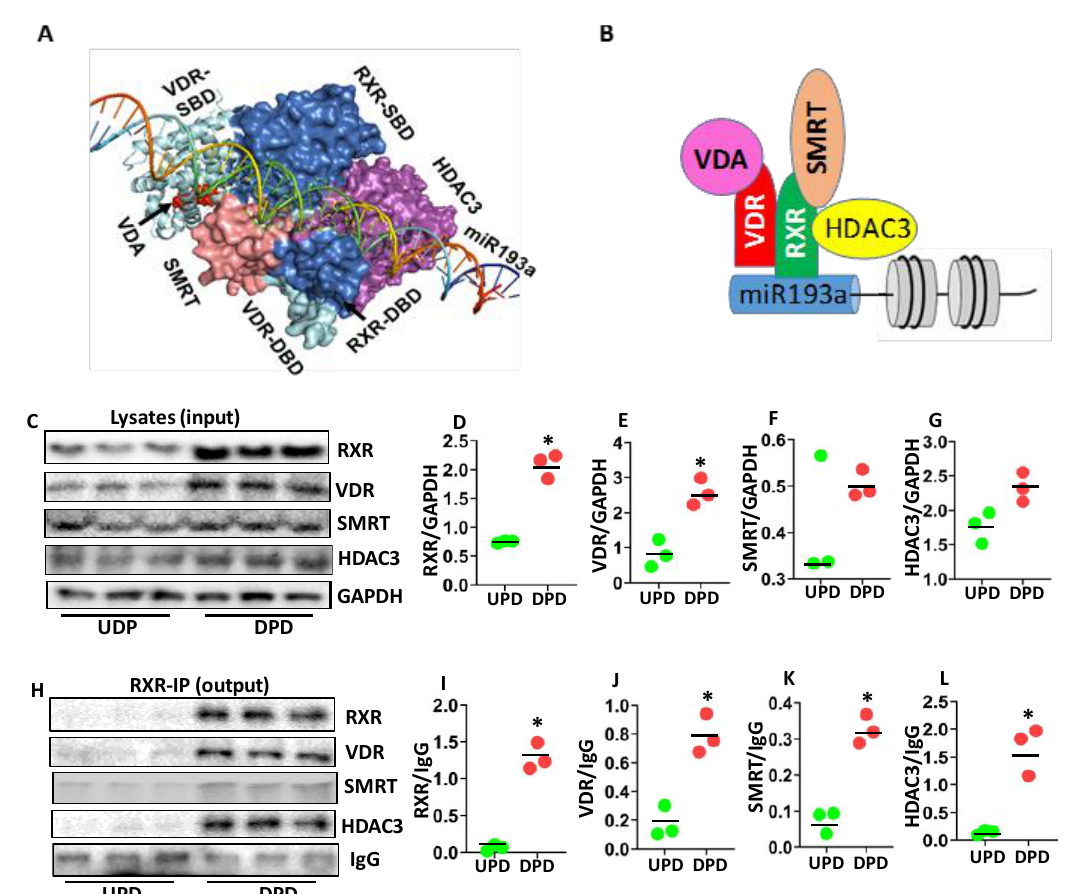
Figure 5. Analysis of VDR-RXR repressor complex. ( A ) The structural construct of the VDR-RXR repressor complex. The complex shows VDR (cyan) and RXR (marine blue) heterodimer. VDA (red) bound with VDR and RXR heterodimer interacts with miR193a promoter and recruits SMRT (pink) and HDAC3 (magenta) and forms a repressor complex. ( B ) A schematic diagram is displaying the formation of the VDR-RXR repressor complex at the miR193a promoter. The VDA bound VDR makes a heterodimer with RXR and recruits SMRT and HDAC3 and forms a repressor complex. ( C ) Protein blots of three different cellular lysates of UPDs and DPDs were probed for RXR, VDR, SMRT, HDAC3, and GAPDH. Gels of three independent lysates are displayed. ( D – G ). Cumulative densitometric data (protein GAPDH) are shown as dot plots. * p < 0.05 compared with respective UPD. ( H ) Cellular lysates from protocol C were immunoprecipitated (IP) with the RXR antibody. Protein blots of RXR-IP fractions were probed for RXR, VDR, SMRT, HDAC3, and IgG. Gels are displayed. ( I – L ). Cumulative densitometric data (protein / GAPDH) from the protocol H, are shown as dot plots. * p < 0.05 compared with respective